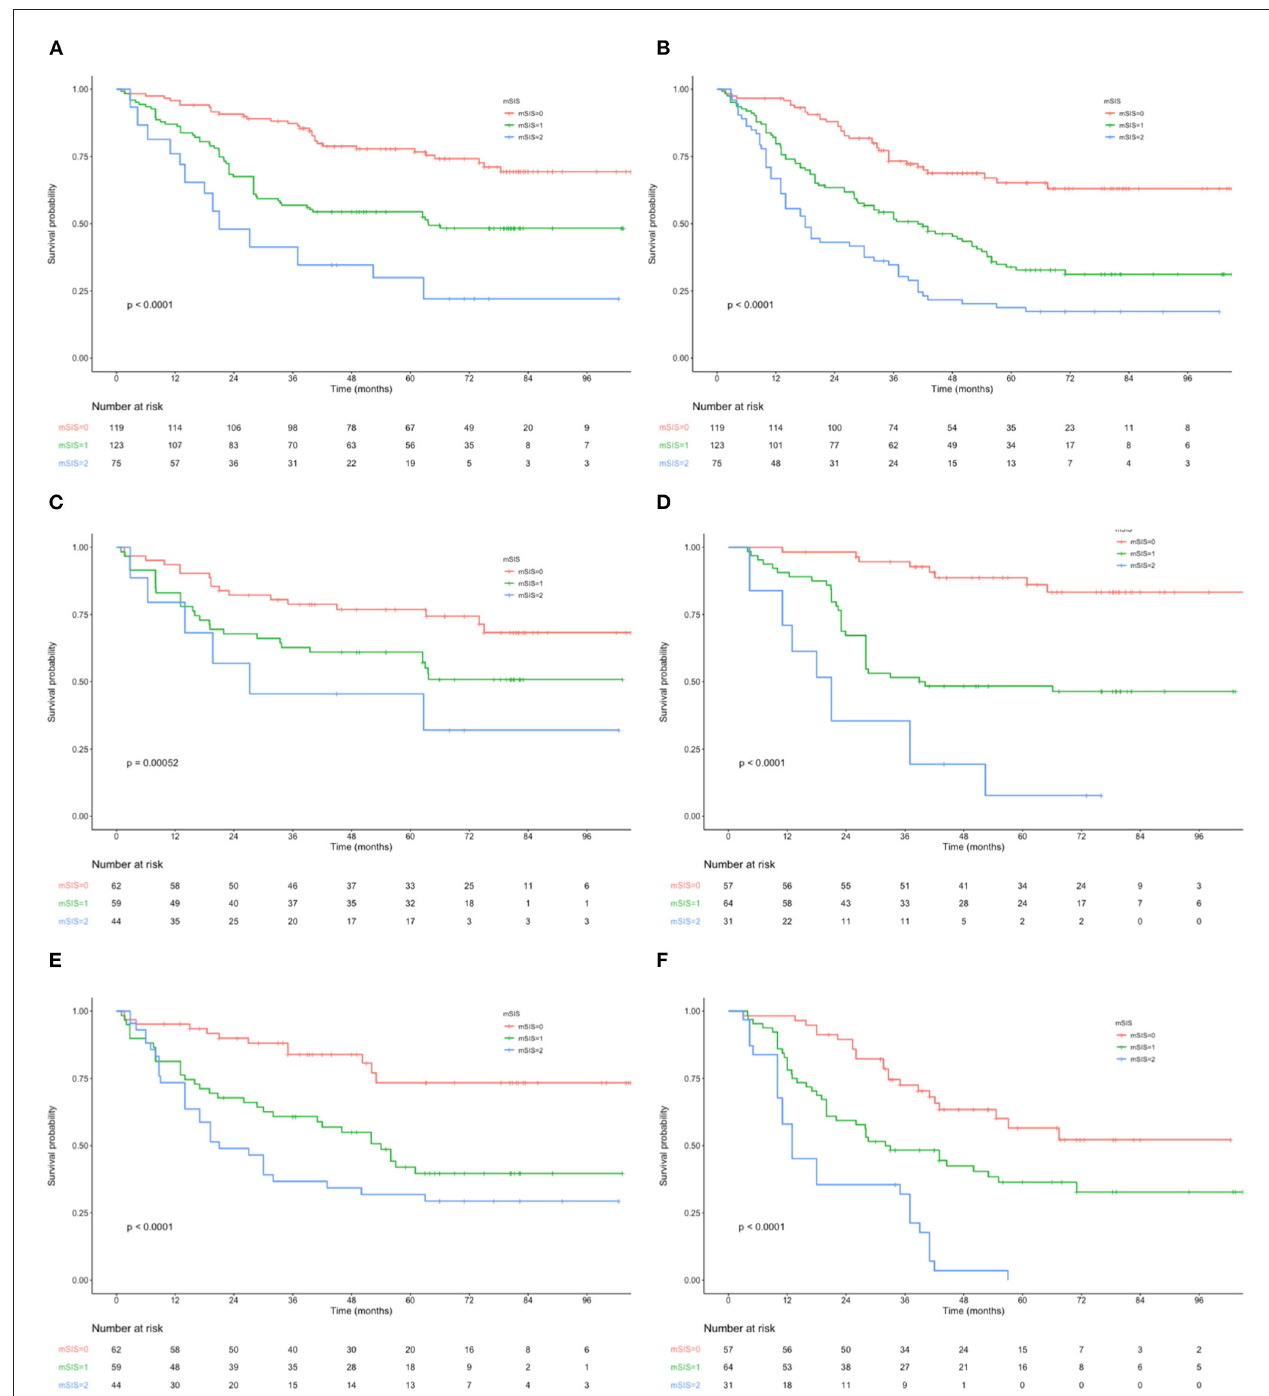
FIGURE 1 | (A) Kaplan–Maier curves of OS for each mSIS group. (B) Kaplan–Maier curves of RFS for each mSIS group. (C) Association of the mSIS with the OS in the adjuvant chemotherapy group. (D) Association of the mSIS with the OS in the surgery-alone group. (E) Association of the mSIS with the RFS in the adjuvant chemotherapy group. (F) Association of the mSIS with the RFS in the surgery-alone group. OS, overall survival; RFS, relapse-free survival; AEG, adenocarcinoma of the gastroesophageal junction; mSIS, modified systemic inflammation score.